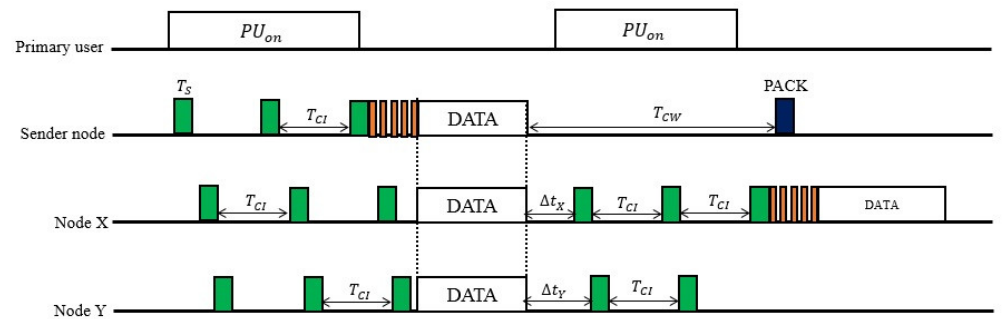
Figure 4. Operation of the CRB MAC Figure 4 . Operation of the CRB MAC protocol.